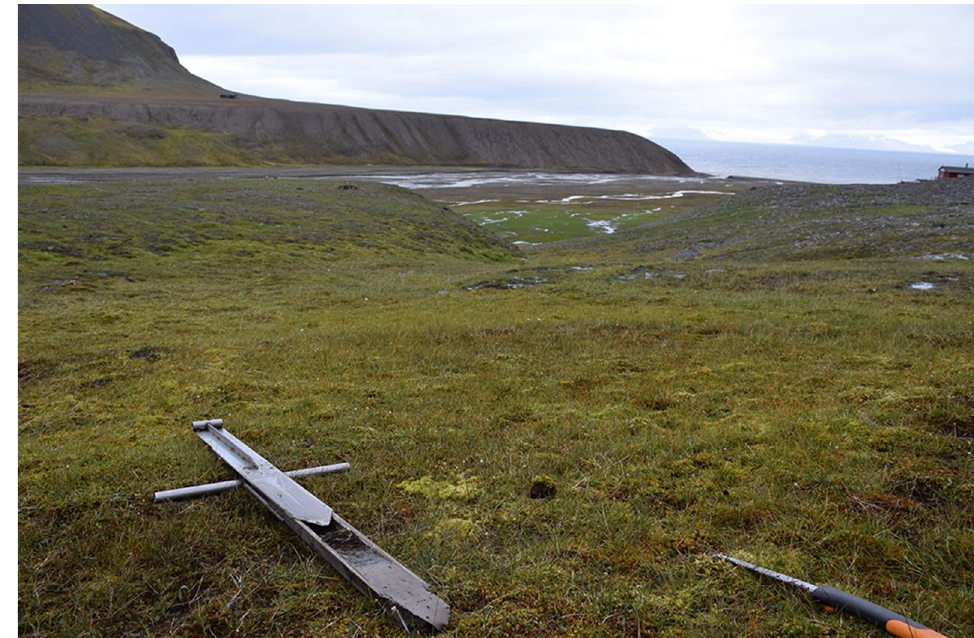
Figure 2. The general view of the Bjørndalen study site. The variations at the local scale can be seen in wet depression with mosses and dry surfaces with grass species.